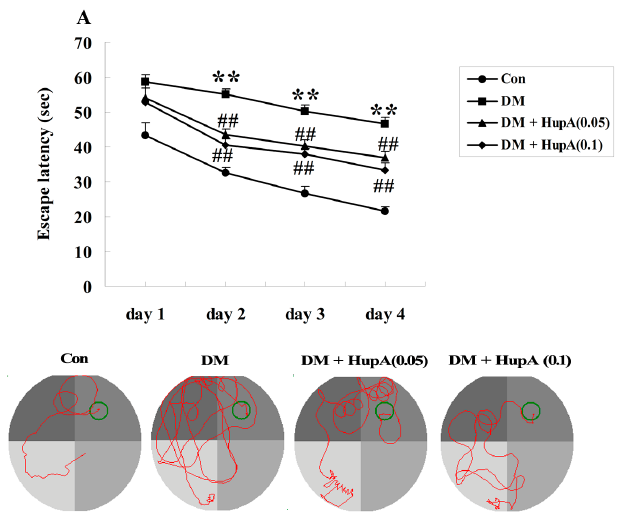
Figure 2. Effects of HupA on the escape latency ( A ); mean path length ( B ); mean percentage of time spent in the target quadrant ( C ); the number of times of crossing platform ( D ) and swimming speed ( E ) in control and diabetic rats ( n = 8, mean ± S.D.). ** p < 0.01 compared with Con group; ## p < 0.01 compared with DM group. Con, control; DM, diabetes; DM + HupA (0.05), huperzine A (0.05 mg/kg)-treated; DM + HupA (0.1), huperzine A (0.1 mg/kg)-treated